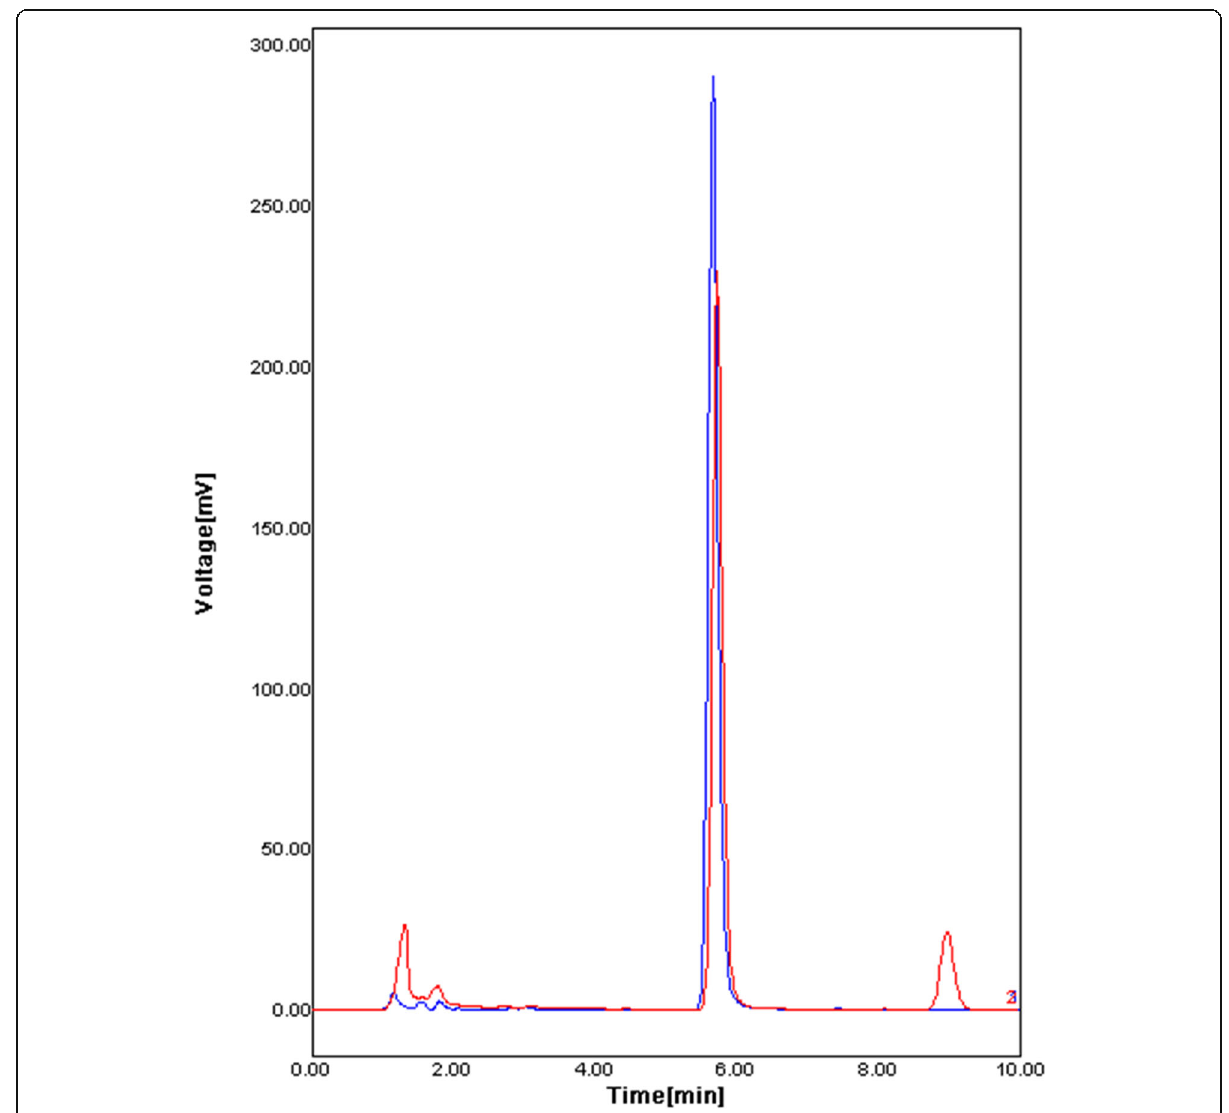
Fig. 5 Overlay of chromatograms of std clotrimazole (blue) and clotrimazole film